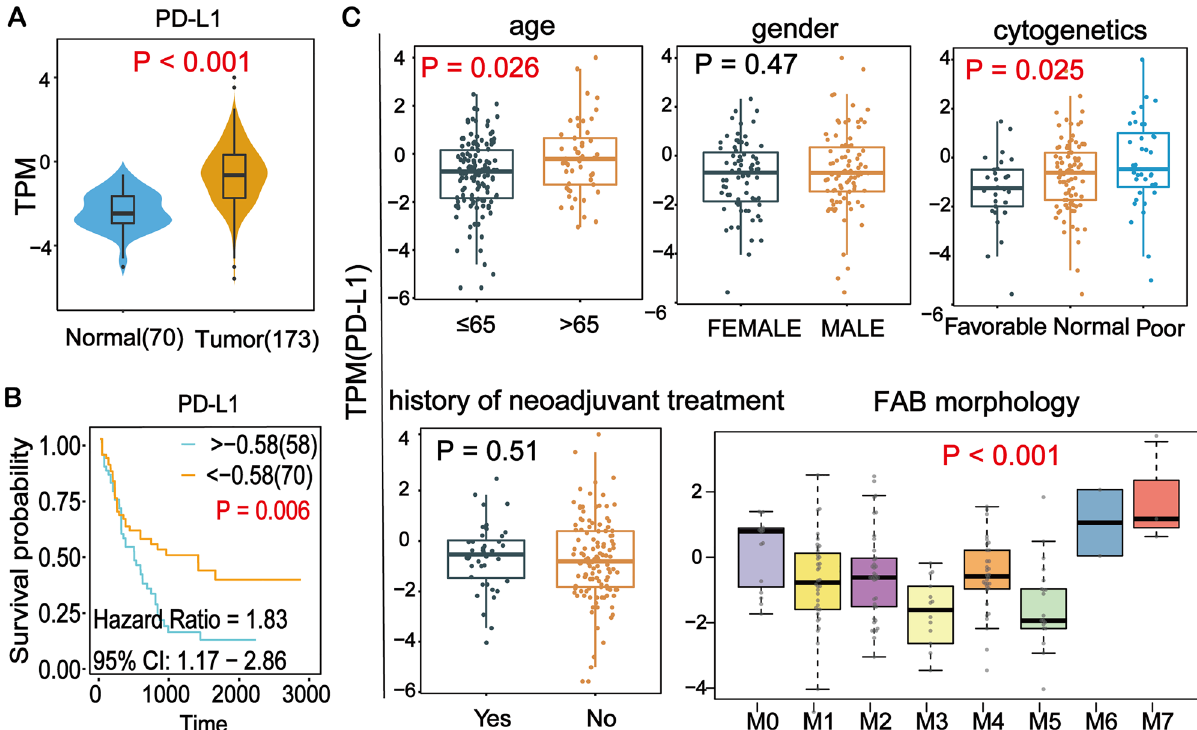
Figure 1. Bioinformatics analysis of PD-L1 expression and its association with survival and clinico-pathological parameters. ( A ) The differential expression of PD-L1 in normal and tumor samples in AML. Wilcoxon test was used to compare the two groups. ( B ) Kaplan–Meier analysis showed worse survival outcome in AML patients with high expression of PD-L1. ( C ) High PD-L1 expression was found in patients with older age (> 65), poor cytogenetics and high FAB morphology. TPM: Transcripts Per